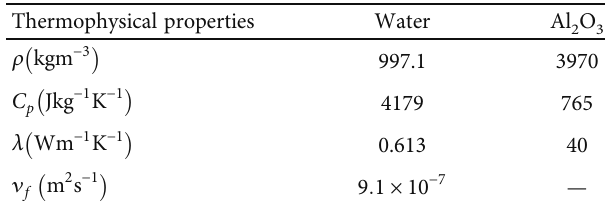
Table 1: Thermophysical properties of water and nanoparticles [69]. Thermophysical